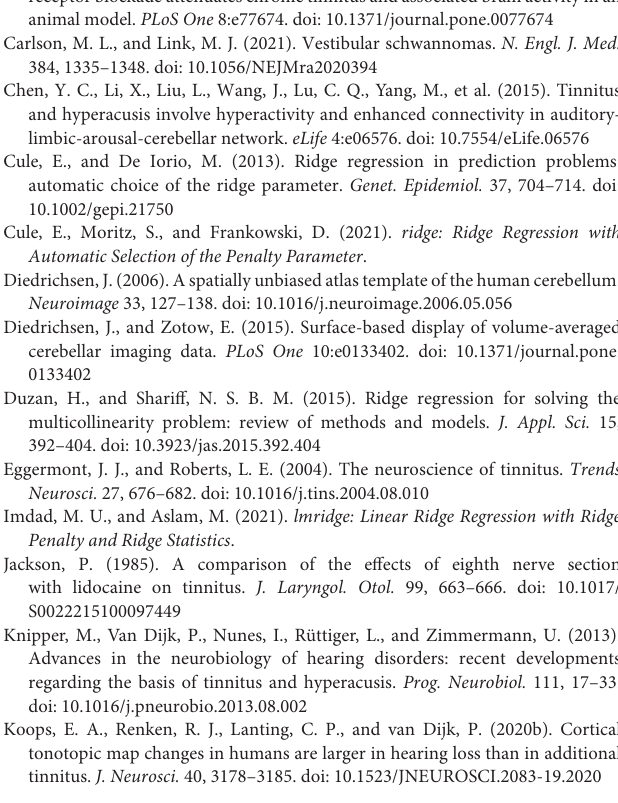
referral tinnitus clinic. Heliyon 7:e07733. doi: 10.1016/j.heliyon.2021.e07733 Shore, S. E., Roberts, L. E., and Langguth, B. (2016). Maladaptive plasticity